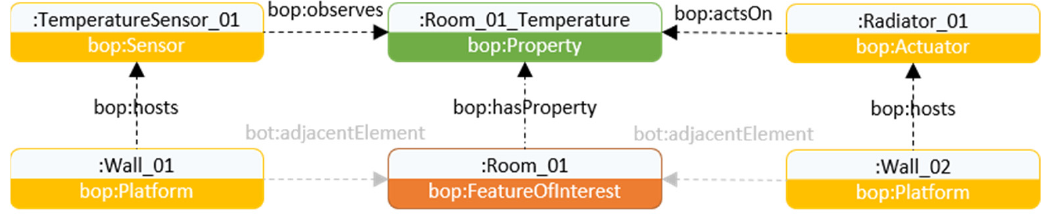
Figure 24. Aligning HVAC systems using BOP.